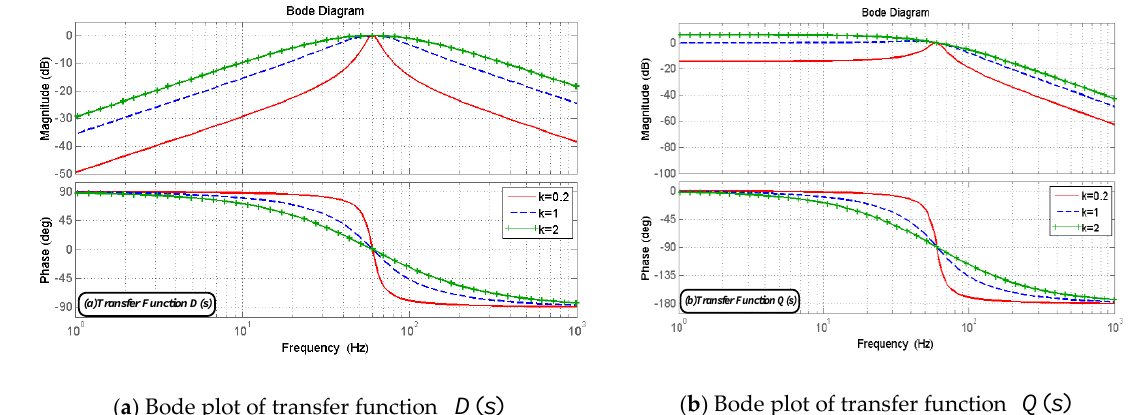
Figure 9. Characteristics of SOGI-based AF various gain k .